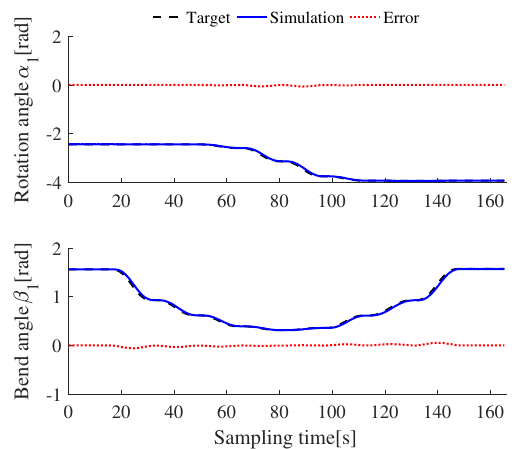
Figure 13. The comparison of the virtual joints in the continuous segment 1.